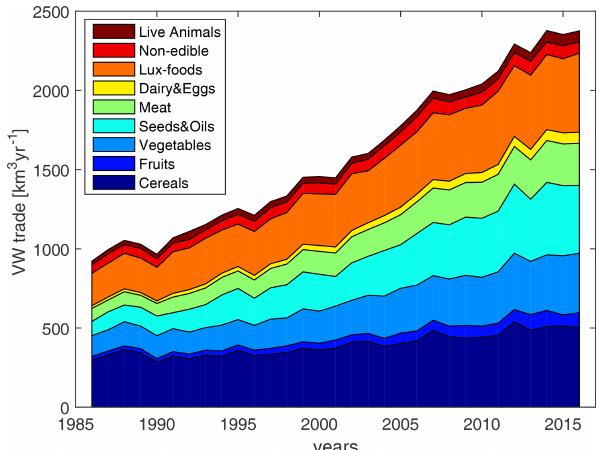
Figure 7. Global virtual water trade (as derived from export data) from 1961 to 2016 considering the nine categories of goods from Fig.